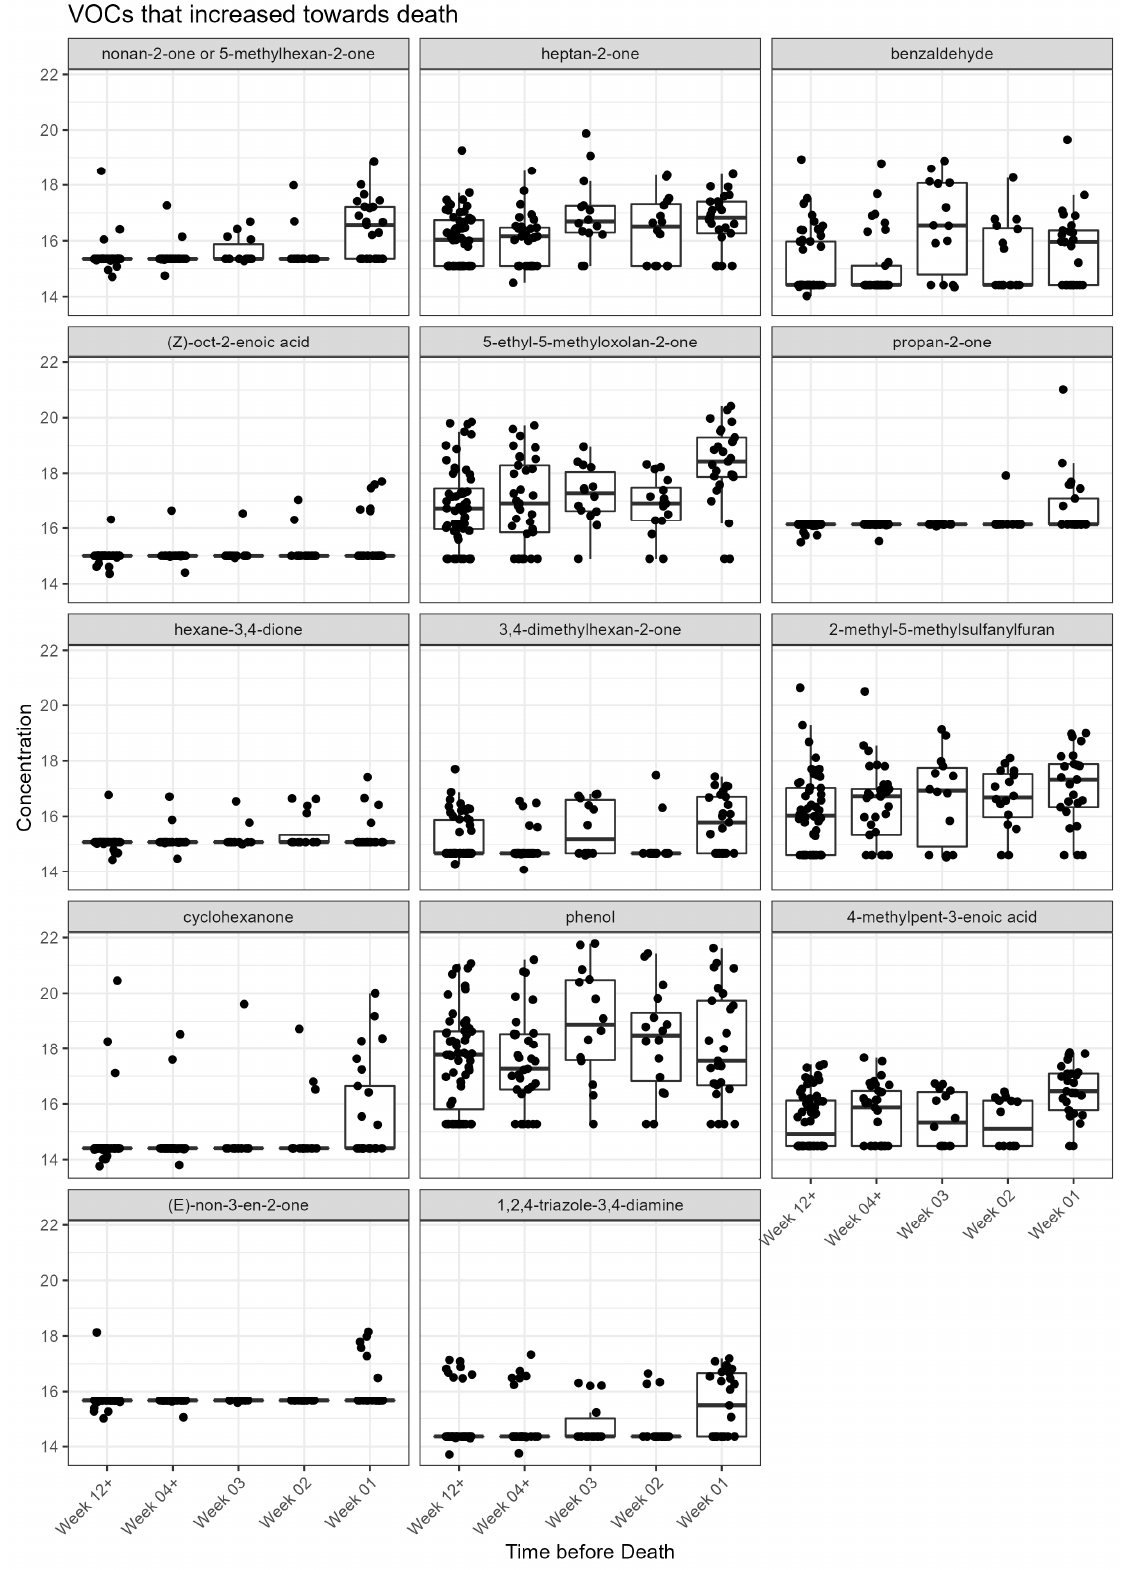
Figure 1. VOCs that increase towards death in the acid dataset. Jitter box plot graph for each metabolite identified as significant from univariate and linear regression analysis. The centre line is the median; box limits are upper and lower quartiles; whiskers are 1.5 × interquartile range; points are individual observations. Y axis is VOC concentration on glog